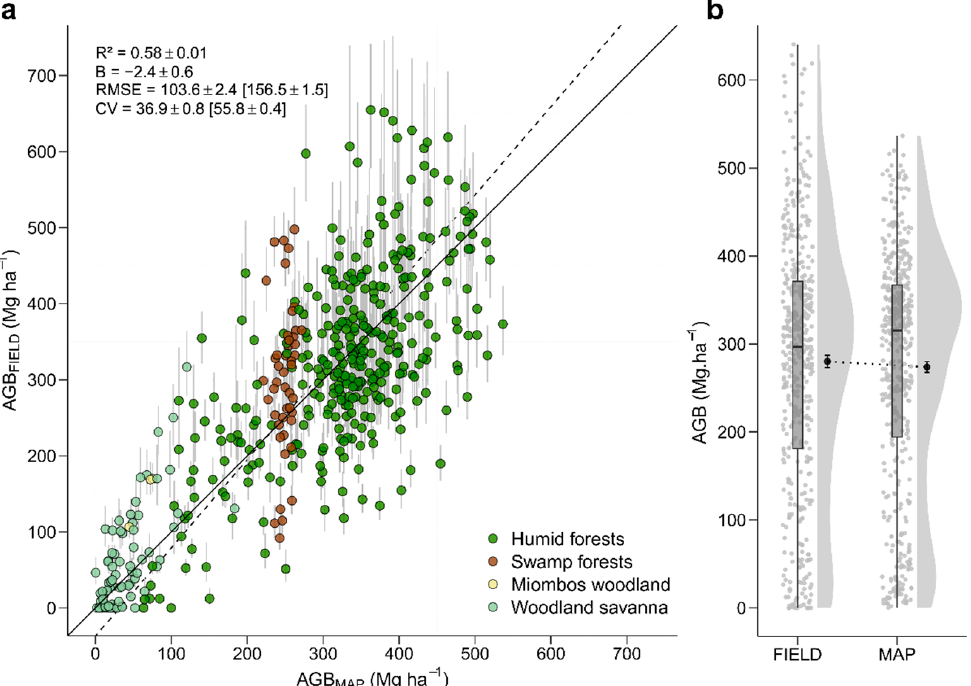
Figure 3. Relationship between sample plots’ aboveground biomass derived from inventory data ( AGB FIELD ) and from the biomass map ( AGB MAP ). ( a ) Scatterplot of AGB FIELD vs. AGB MAP . AGB FIELD predictions are bounded by their 95% confidence intervals including uncertainties arising from the simulation of missing inventory data, WD, h and the allometric model (gray segments). The dashed line represents the fit of a major axis regression. ( b ) Distributions of AGB FIELD and AGB MAP . Distribution means are represented with thick circles (bounded by ± one s.e.). Dotted lines connect distribution means between data sources (i.e., forest inventories or biomass map).